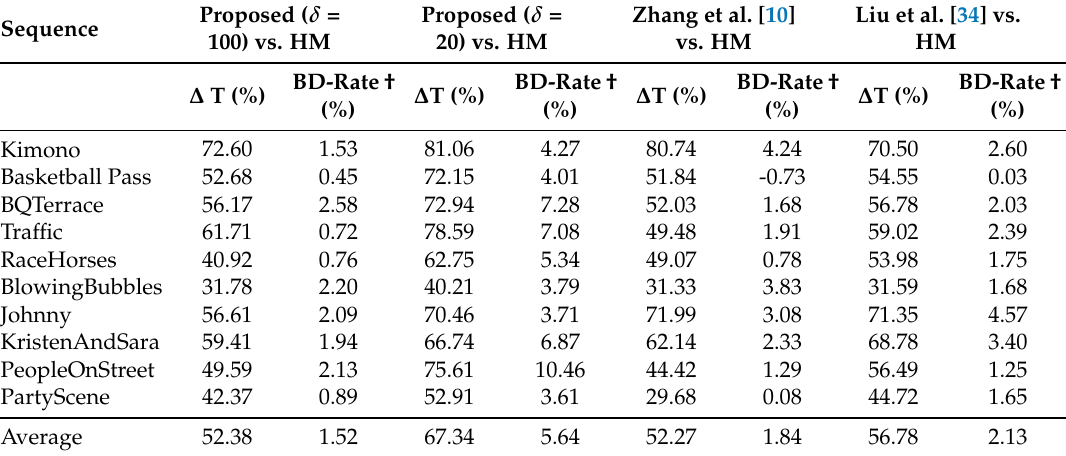
Table 4. Coding efficiency and complexity reduction performance (All Intra